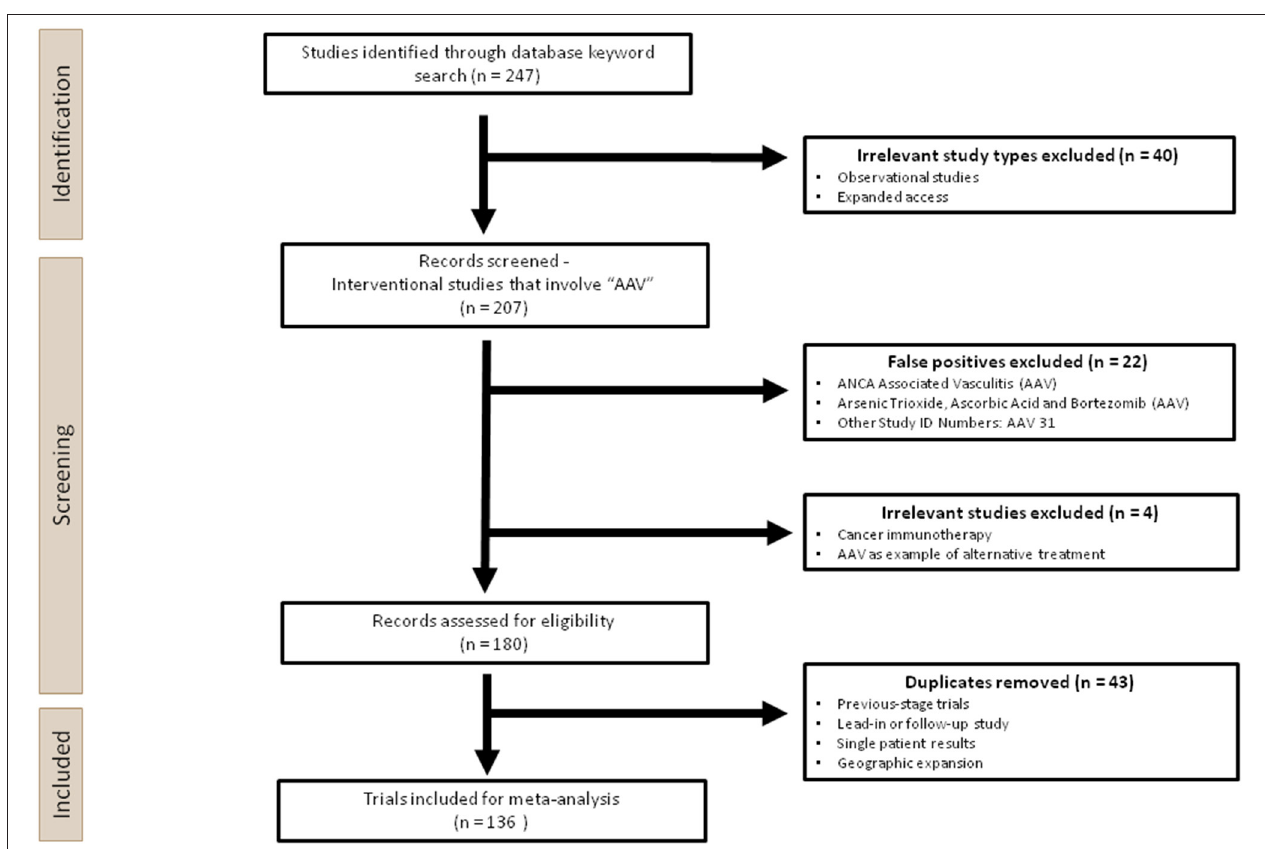
FIGURE 2 | Overview of the experimental design used in this analysis. Two hundred forty-seven clinical trials were first identified through a keyword search for “AAV” on ClinicalTrials.gov. Two hundred seven interventional studies were screened, during which irrelevant studies, false positives and duplicates were removed manually. One hundred thirty-six trials were ultimately included for the